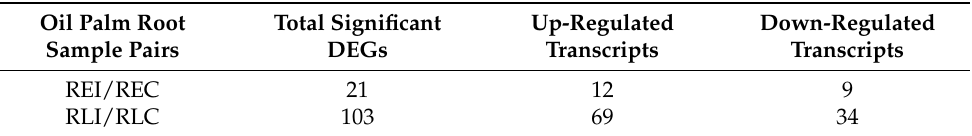
Table 2. Summary of total significant differentially expressed genes (DEGs) for oil palm root samples pair and the number of transcripts